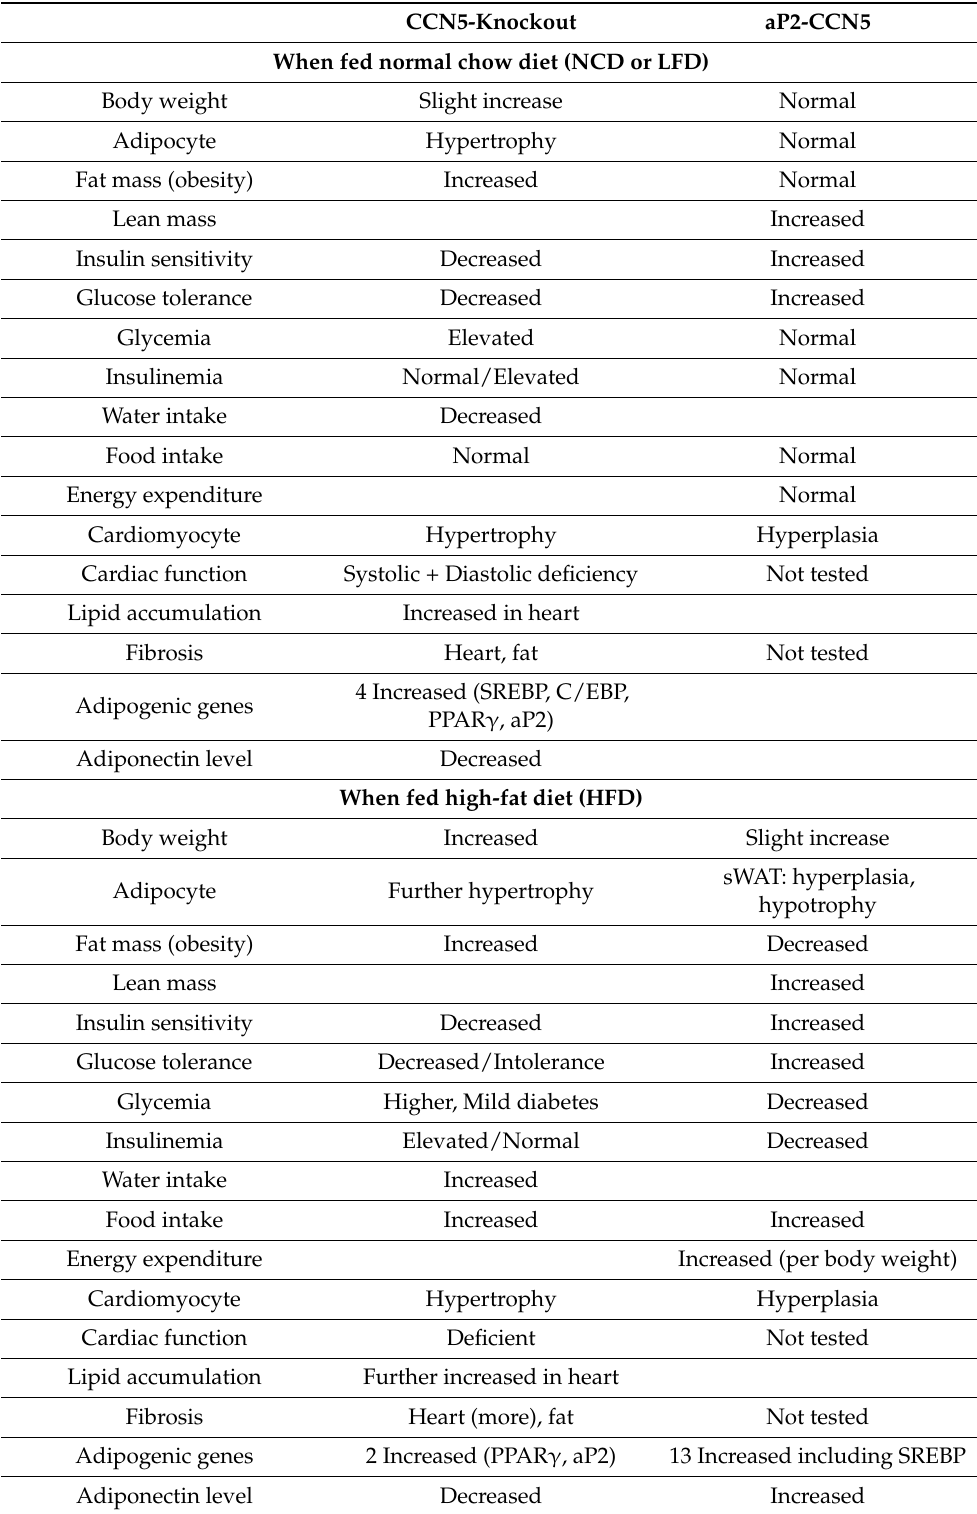
Table 1. Differential phenotype caused by CCN5 gene deficiency vs. adipocyte-specific overexpres- sion, based on two reports and a review